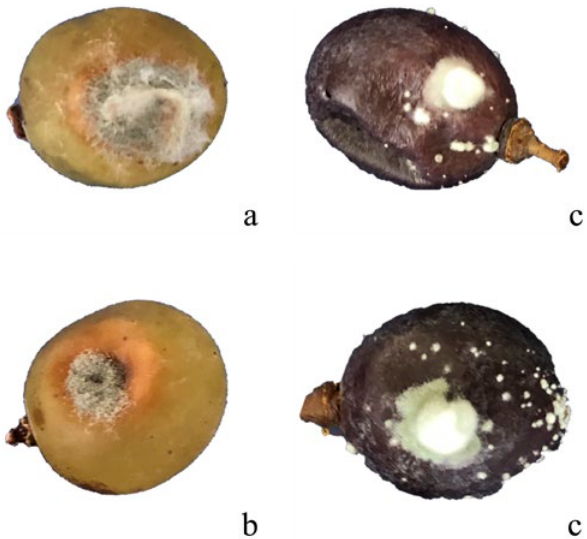
Figure 5. Details of the pathogenicity assay of ITEM 18277 (isolate Pdb1) (a and c) and ITEM 18276 T (isolate P3) (b and d) on white fresh table grapes (left) and red withered wine grapes